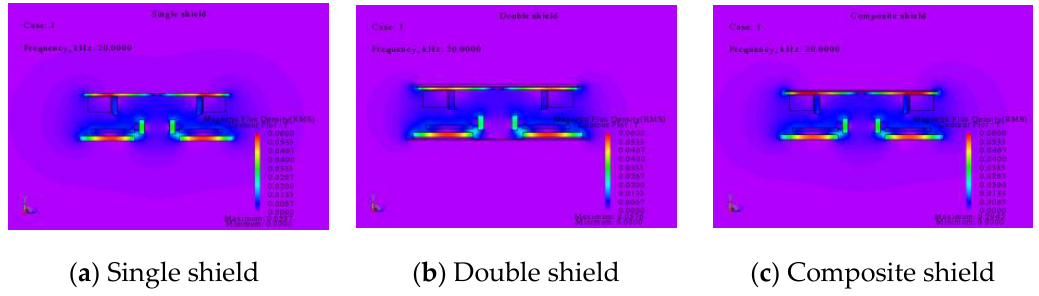
Figure 6. Simulated magnetic flux density distribution in a cross-section of different types of magnetic coupler.